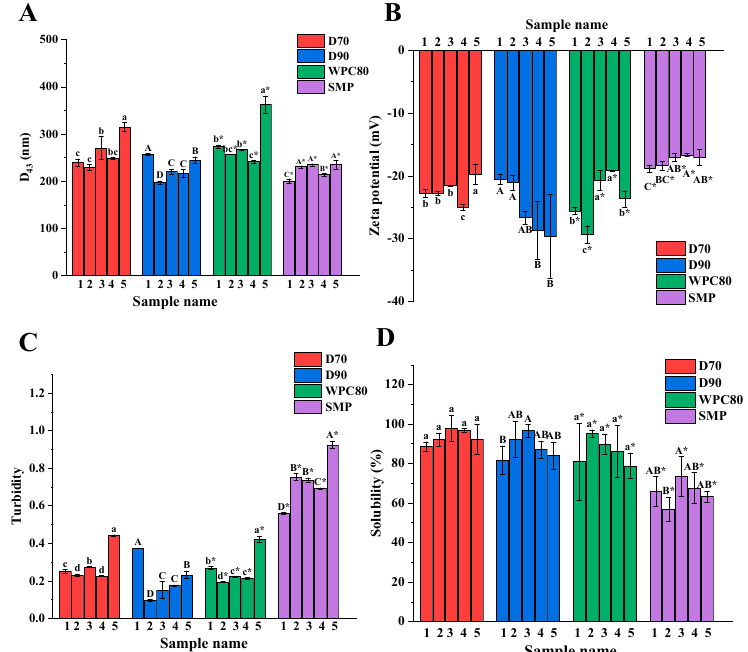
Figure 2. Physicochemical properties of D70, D90, WPC, and SMP samples from different manufac- turers. Particle size ( A ), zeta potential ( B ), turbidity ( C ), and solubility ( D ). Different letters (a–d, A–D, a*–d*, A*–D*) indicate significant differences at p < 0.05.